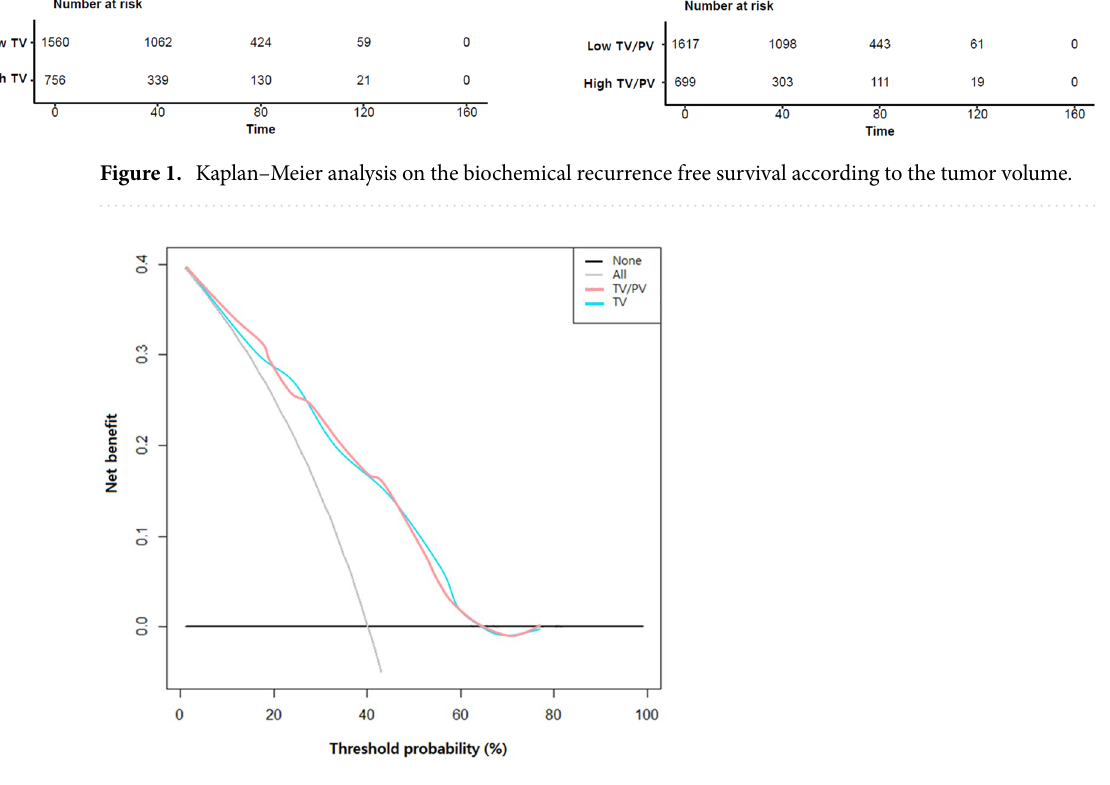
Figure 2. Decision curve analysis of TV and TV/PV for biochemical recurrence